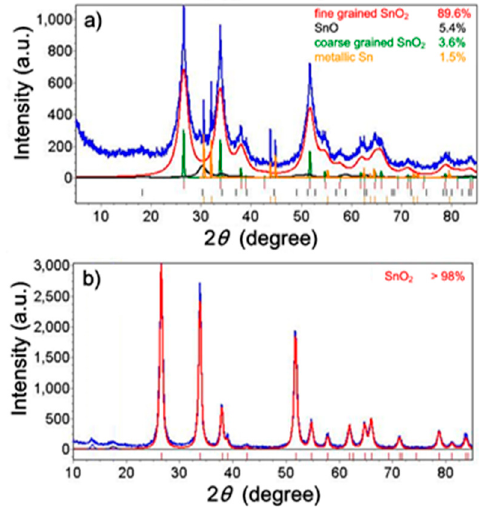
Figure 2. Results of XRD phase analysis of as-synthesized ( a ) and annealed ( b ) powders. The measured spectra are shown in blue. Other spectra calculated by the Rietveld method correspond to crystalline phases indicated in the upper right area of each figure.